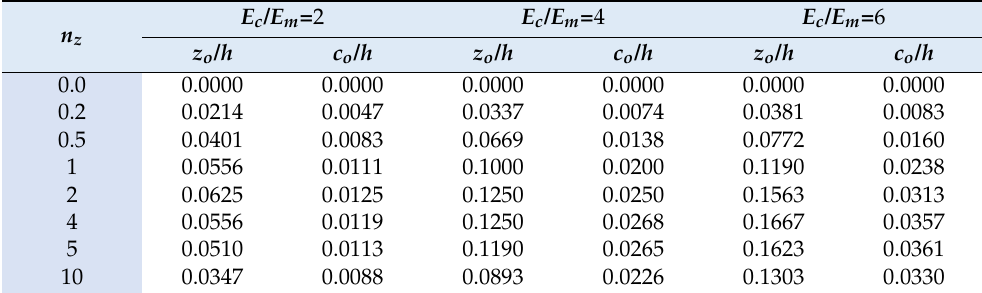
Table 7. Maximum values of z 0 / h and c 0 / h at different n z and E c / E m ratios ( n x = 1 ) .